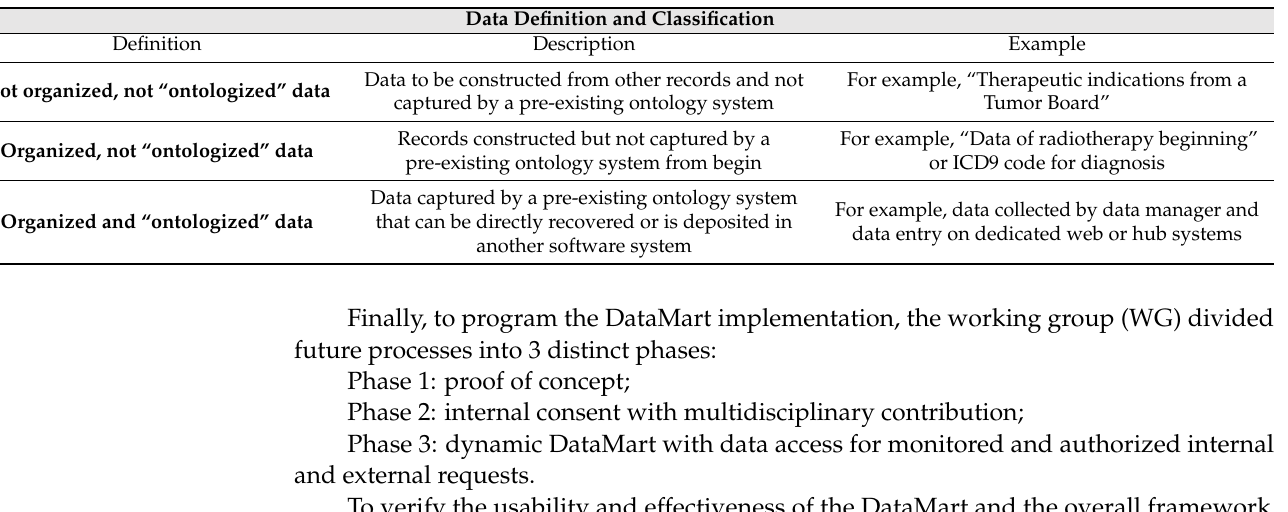
Table 1. Data definition and classification, according to their